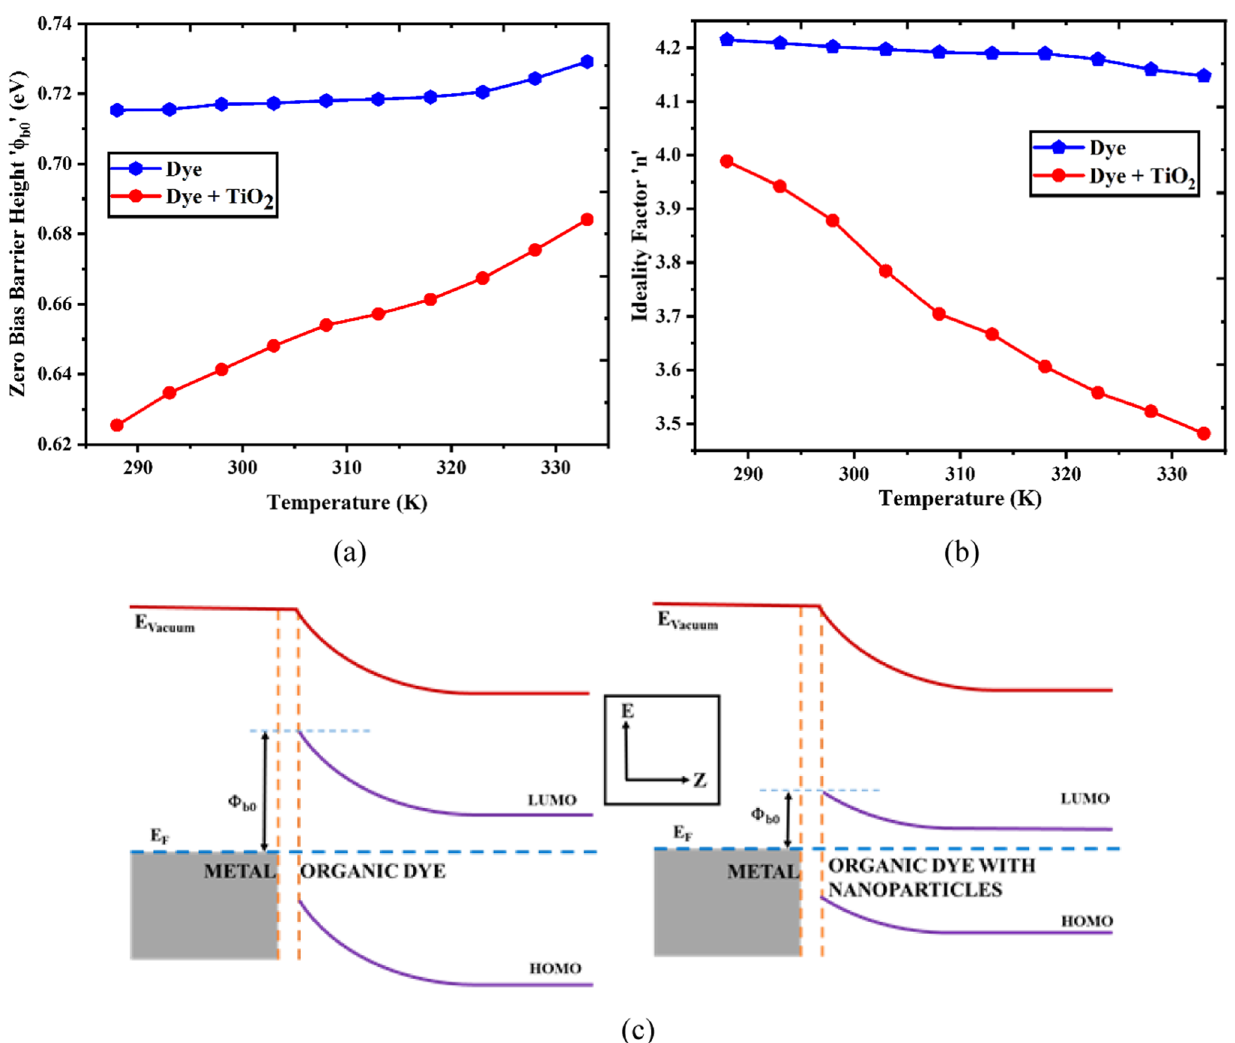
Fig.7 Dependency of ϕ b 0 and n with temperature for TZ dye a without TiO Band Diagram for metal organic contact Table 2 Room temperature zero bias barrier height and ideality factor for TZ dye with and without TiO